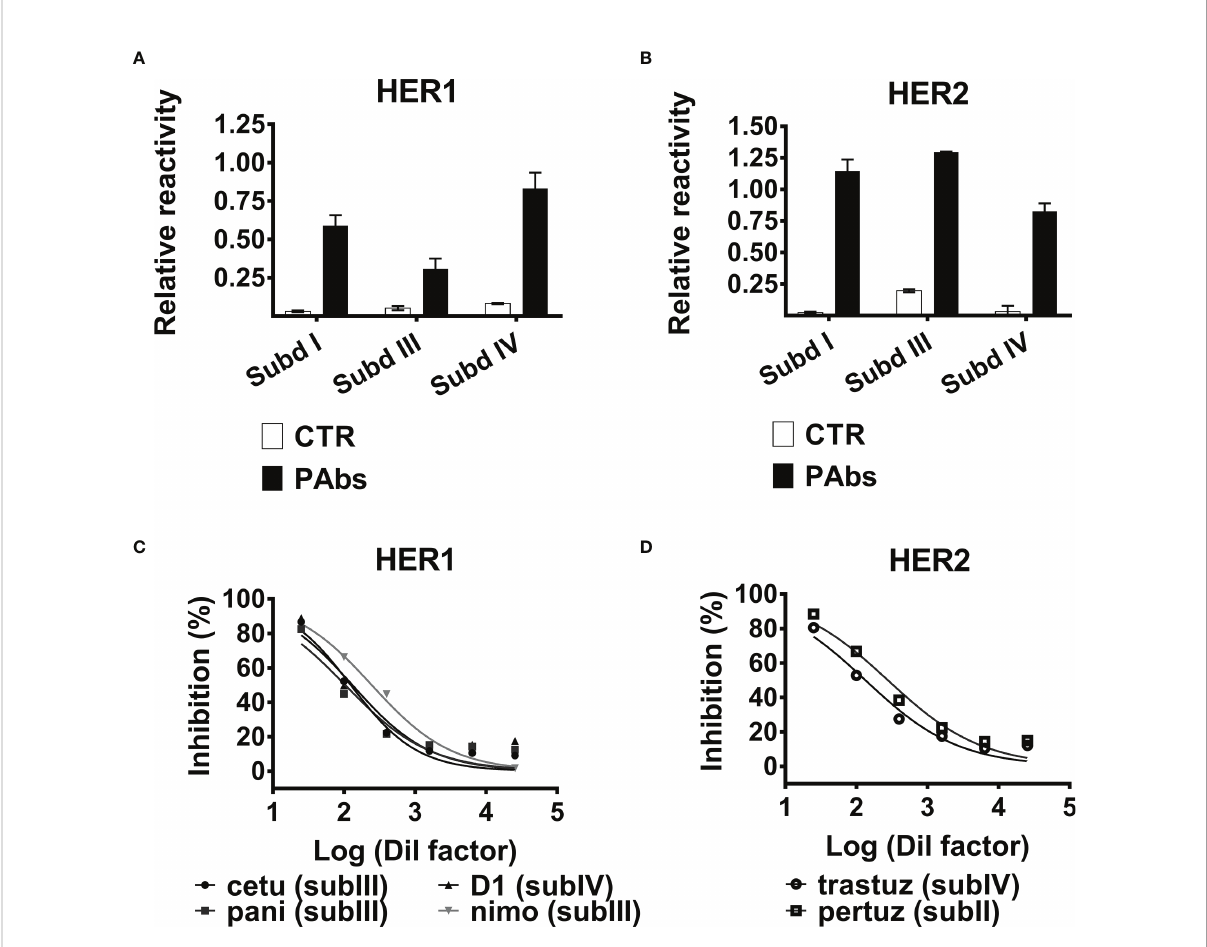
FIGURE 1 Recognition of HER1/HER2 subdomains by the PAbs and inhibition of MAbs binding. Recognition of (A) HER1 or (B) HER2 subdomains I, III, and IV expressed on phages by the PAbs (10 µg/ml) assessed by ELISA. Samples were normalized against the absorbance obtained for the recognition of 9E10MAb. PAbs from non-immunized mice (CTR PAbs) were included as control. Graphs represent the increase of the absorbance at 490 nm corresponding to the recognition of each subdomain by speci fi c or control PAbs, normalized considering the absorbance of the 9E10 control and expressed as relative reactivity. (C) HER1-ECD-coated plates were incubated with dilutions of PAbs- containing immune sera; next, the binding capacity of MAbs was evaluated by ELISA. Graphs represent the inhibition of HER1-ECD-targeting cetuximab (cetu, black circle), panitumumab (pani, black square), nimotuzumab (nimo, gray inverted triangle), and D1 (black triangle). Inhibition was expressed as percentage considering binding of the MAbs in the absence of PAbs as maximum reactivity control, and data were adjusted to a non-linear “ response vs . log (inhibitor) ” regression with variable slope. (D) Likewise, it was evaluated the inhibition of the binding of HER2-ECD recognizing trastuzumab (trastuz, open circle) and pertuzumab (pertuz, open square), mediated by the PAbs. A representative experiment of three performed is